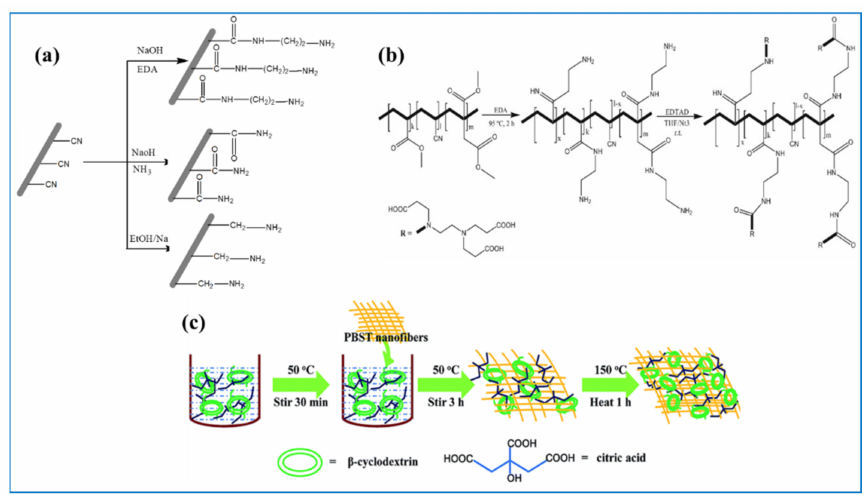
Figure 7. ( a ) surface functionalization of PAN by EDA, NH 3 and EtOH/Na [67], Copyright © (2020)